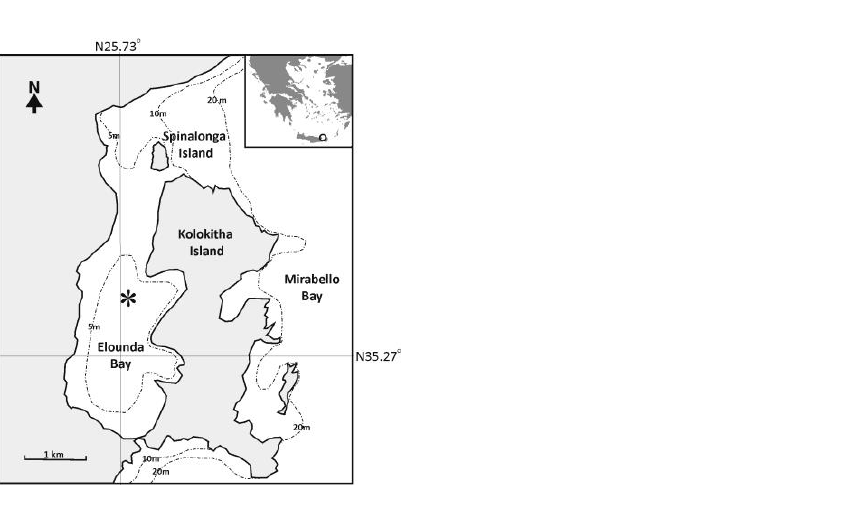
Figure 1. Map showing the study area of Elounda Bay. Asterisk represents the sampling site. Depth contours of 5 m, 10 m and 20 m are also indicated. Table 1. Fish species and number of specimens examined for stomach content analysis during all six sampling occasions in the study area. The numbers of empty stomachs, in terms of vacuity index, are also shown. Size range of the total length (TL) of the fish specimens is given. L m : length at first maturity for each species is also